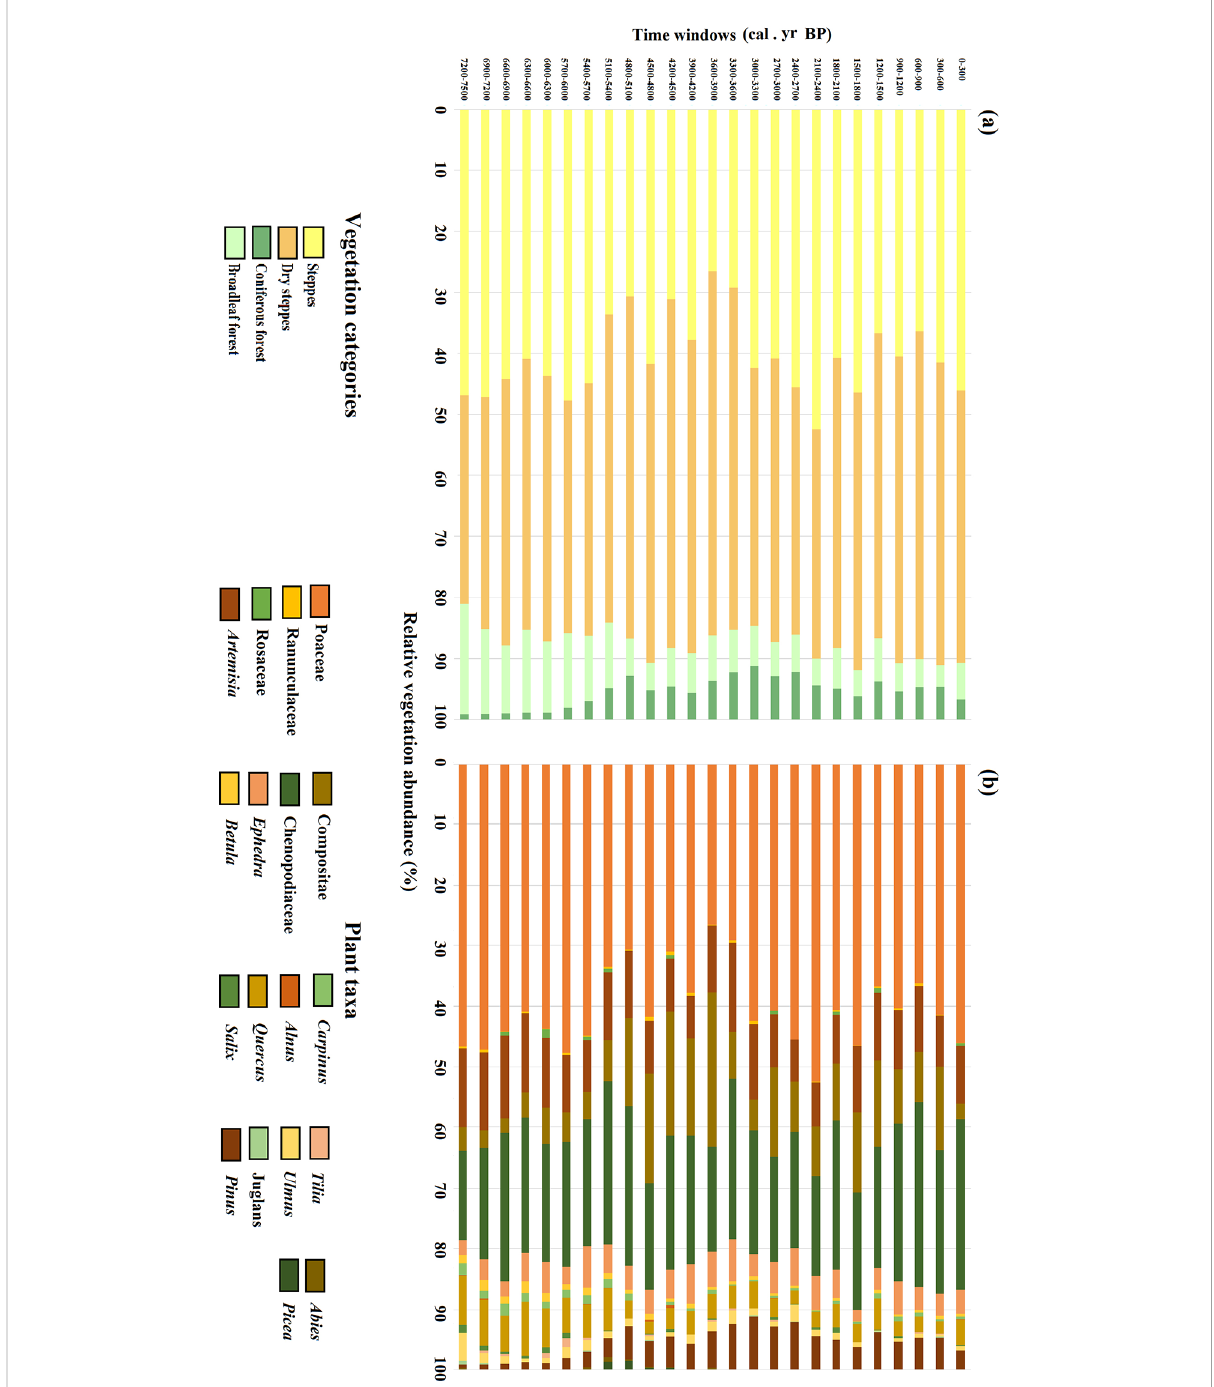
FIGURE 3 Past vegetation reconstructions based on REVEALS using S4 with a wind speed of 6 m/s for the central region. The four vegetation categories (A) and individual plant taxa (B) are